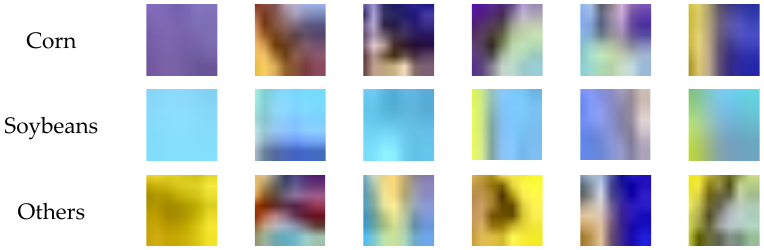
Figure 4. Part of the training examples.